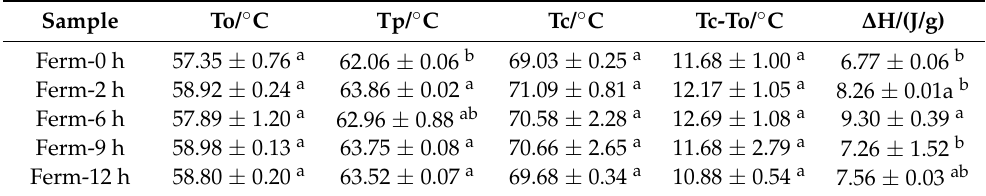
Table 1. Thermal properties of wheat starch separated from bifidobacteria-fermented dough at different fermentation